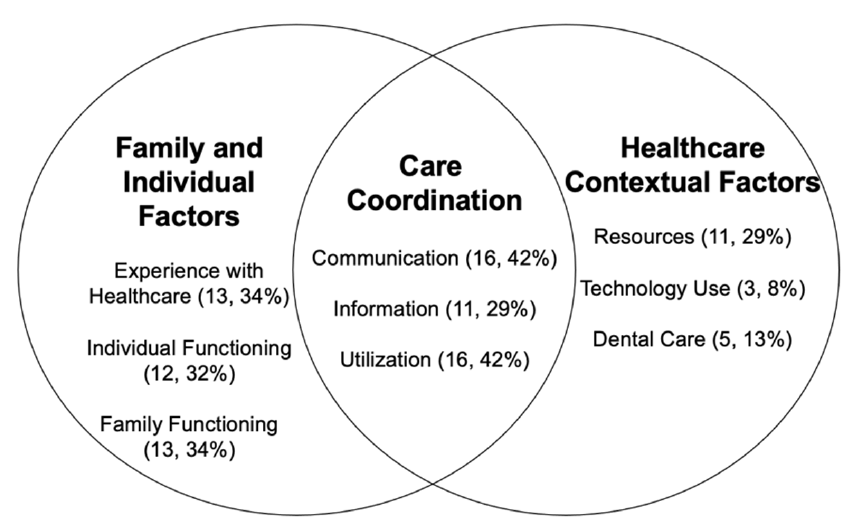
Figure 2. Themes related to care coordination. Number of studies addressing theme included in review, percentage of studies in review.